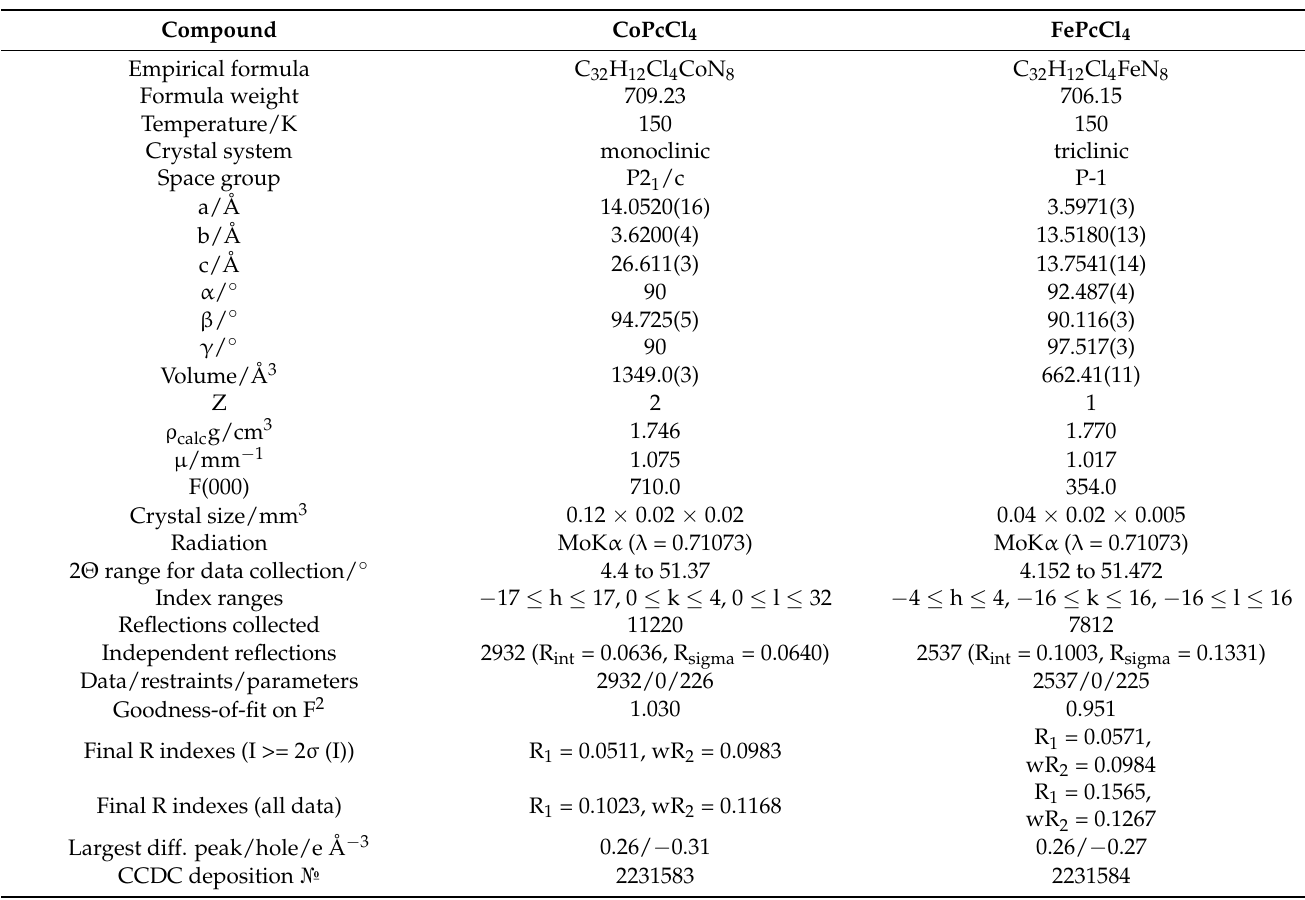
Figure 3. Molecular packing diagrams for CoPcCl 4 ( a , b ) and FePcCl 4 ( c , d ). Table 1. Unit cell parameters and refinement statistics for CoPcCl 4 and FePcCl 4 .